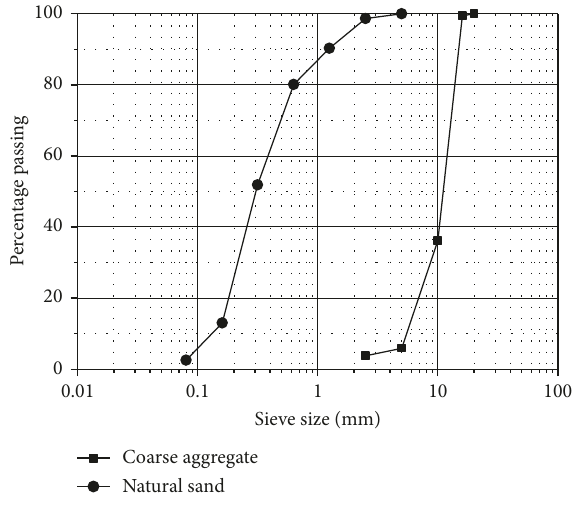
Figure 1: Grading curves for fine and coarse aggregates. Table 1: Designed concrete mix proportions (kg/m 3